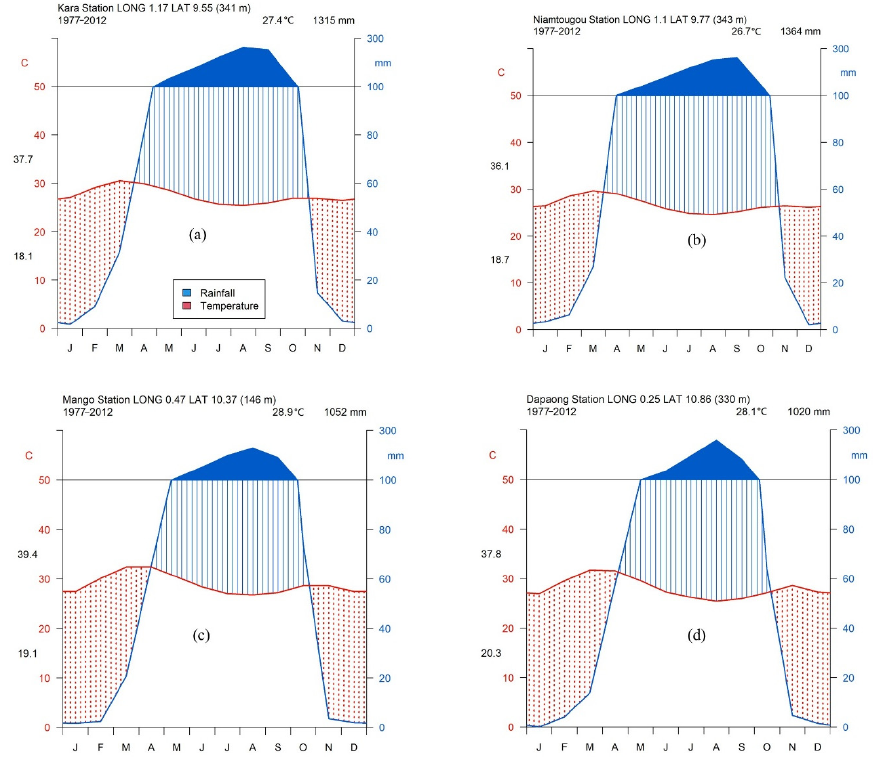
Figure 2. Walter–Lieth (1967) climate diagrams for northern Togo based on data collected at four meteorological stations: ( a ) Kara, ( b ) Niamtougou, ( c ) Mango and ( d ) Dapaong. The values at the top of the graphs indicate the long-term annual mean temperature and total rainfall. The value at the top left of the temperature axis stands for the mean of the average daily maximum temperature of the hottest month; the value at the bottom of the same axis represents the mean of the average daily minimum temperature of the coldest month. The horizontal black line at 100 mm and 50 °C illustrates the threshold beyond which rainfall scales by factor 10. The blue line represents the annual cycle of monthly rainfall. The red line indicates the annual cycle of monthly mean temperature. The area with blue shaded lines illustrates the humid conditions below the threshold, whereas the area dotted in red indicates the arid conditions. The area filled in blue shows the humid conditions above threshold (excess of